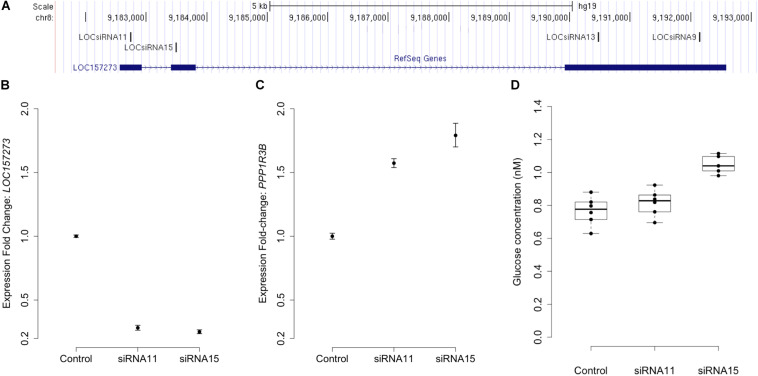
siRNA knockdown of LOC157273 in human hepatocytes with rs4841132 G/G genotype reduces LOC157273 lncRNA levels and increases both PPP1R3B mRNA levels and glycogen deposition. Panel (A) shows a UCSC Genome Browser view of the genomic position on chromosome 8 (hg19) of LOC157273 (sense) and four siRNA constructs (antisense). siRNA-11 and siRNA-15, the most efficient constructs, targeted exons 1 and 2 of the lncRNA. Panel (B) shows expression fold change of LOC157273 mRNA and Panel (C) shows PPP1R3B mRNA, after knockdown with siRNA11, siRNA15, and control. Error bars represent standard errors of normalized Taqman qRT-PCR expression normalized and averaged over three biological replicates. Panel (D) shows human hepatocyte glycogen content (six replicates per condition) after knockdown with siRNA11, siRNA15, and control in one biological replicate.